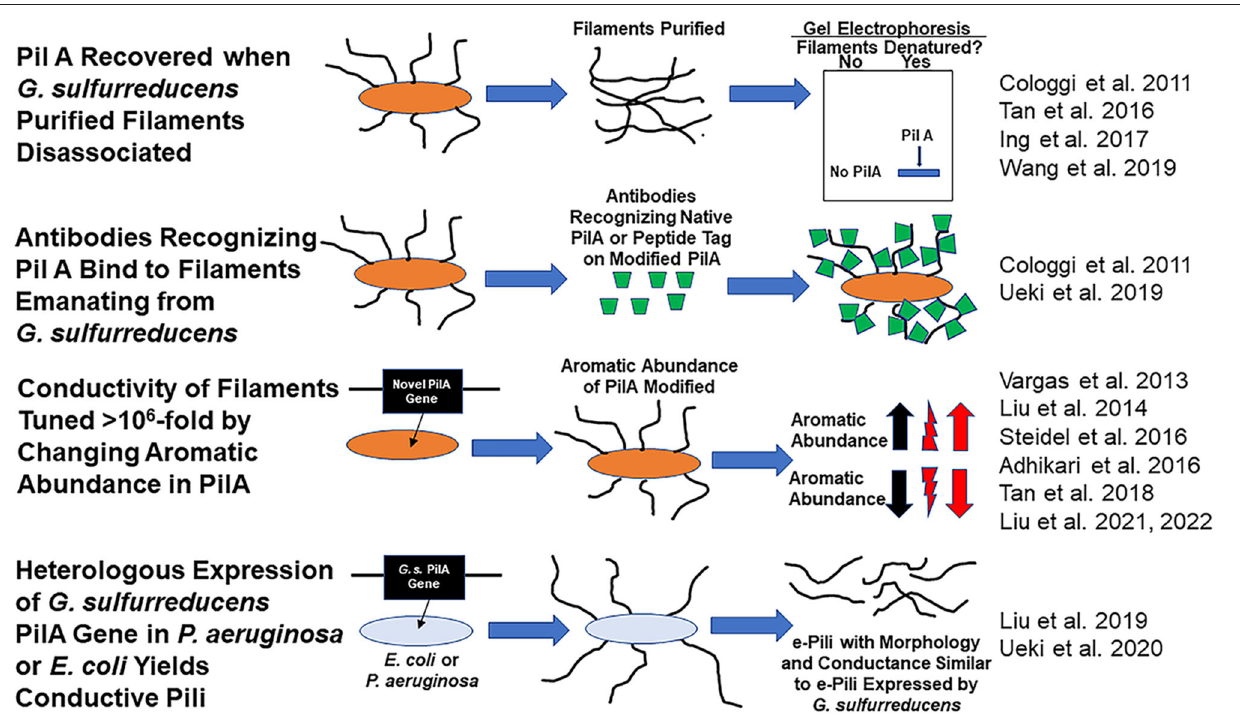
FIGURE 1 | Evidence consistent with the hypothesis that Geobacter sulfurreducens expresses e-pili comprised of the pilin monomer, PilA and that PilA can be assembled into conductive